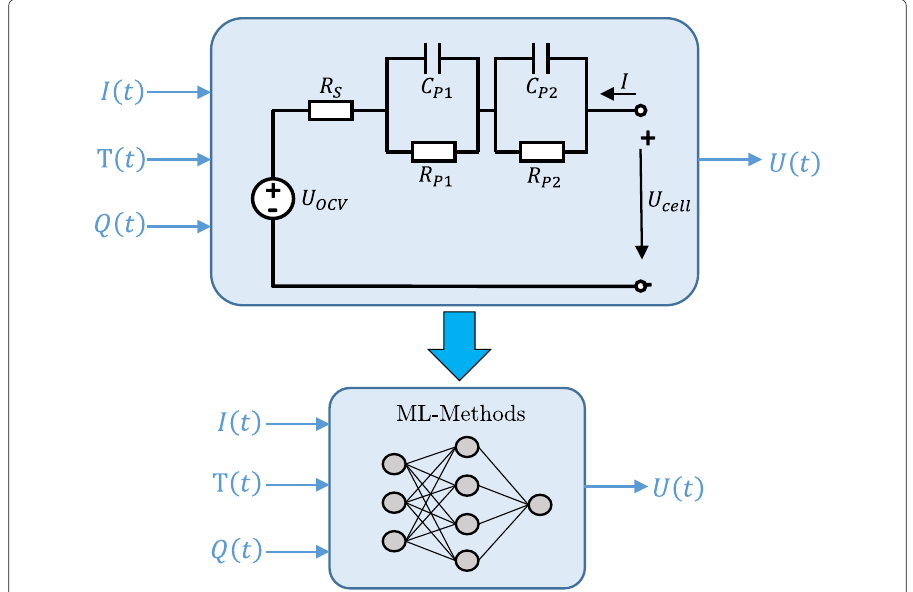
Fig. 2 ML methods replace physical based